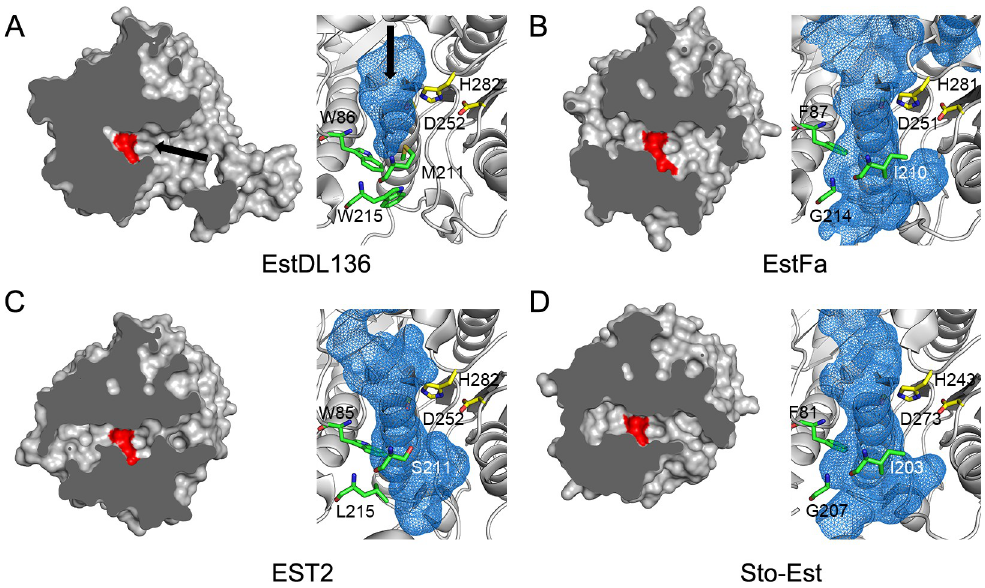
Fig 3. Active site of EstDL136 and other HSLs with different substrate specificities. (A–D) EstDL136 (A) and three other HSLs from Fig 1B are shown: EstFa (B), EST2(M211S/R215L) (C), and Sto-Est (D). All four structures are superimposed and presented in an identical orientation. A surface representation of each enzyme is shown in the left panel. Catalytic residues are shown in red, and the active site entrance is indicated with an arrow. In the right panel, a potential position for the active site, calculated by the program PyMol, is indicated in blue, while catalytic histidine and aspartate residues are shown in yellow. Three residues, Trp86, Met211, and Trp215, occluding the active site pocket in EstDL136 are represented in green. Structurally equivalent residues in other HSLs are also indicated (see Fig